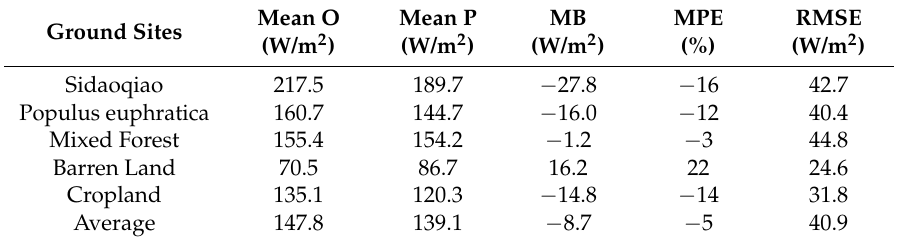
Table 5. Error metrics of instantaneous LE estimates from MODIS and Landsat 8 data. Mean O: mean observation; Mean P: mean prediction; MB: mean bias; MPE: mean percent error; RMSE: root mean square